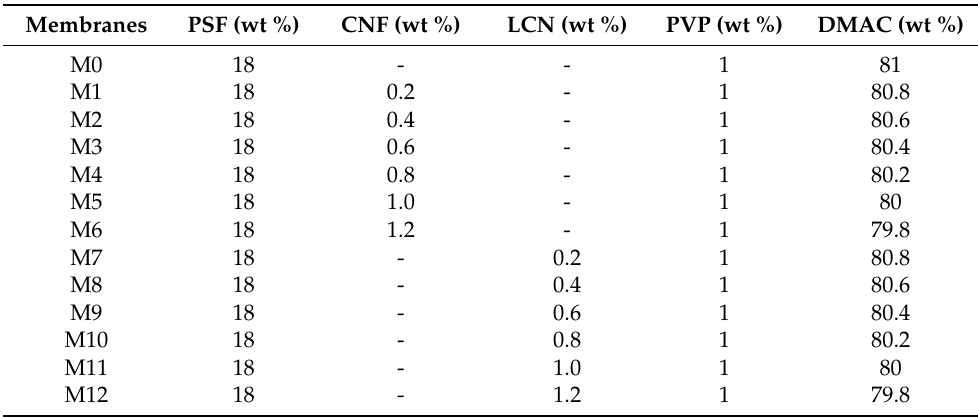
Table 1. Composition of casting